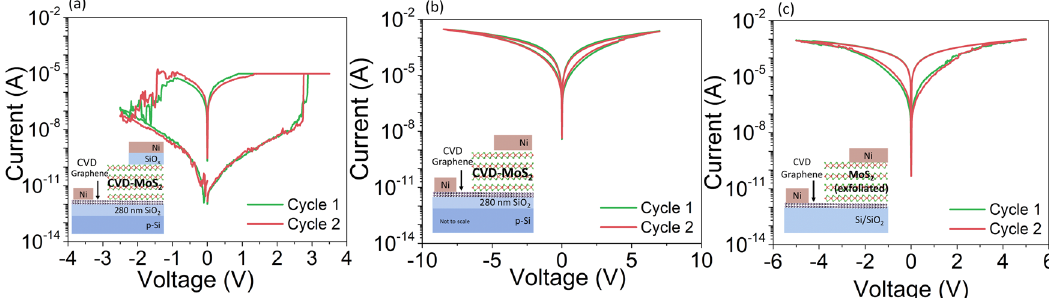
Fig. 2 DC characteristics. a I-V characteristics, with two consecutive SET-RESET cycles, of graphene / MoS 2 /SiO x device exhibiting forming-free behavior. Presence of SiO x is necessary in obtaining high ON/OFF ratio, low programming voltage and 10 3 × reduction in RESET power. Inset: Device schematic. b DC I-V characteristics of graphene/MoS 2 /Ni device fabricated using CVD MoS 2 without SiO x where the gradual transition is observed. The device exhibits low ON/OFF ratio, high programming voltage and high RESET power indicating the necessity of MoS 2 /SiO x active medium. Inset: Device schematic ( c ): DC I-V characteristics of graphene/MoS 2 /Ni device using exfoliated MoS 2 showing characteristics similar to that of graphene/CVD-MoS 2 /Ni. Inset: Device